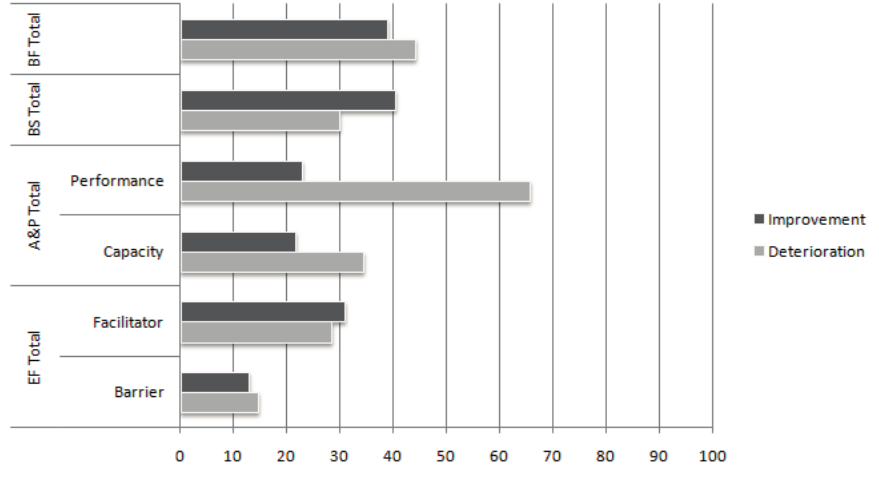
Figure 2. Comparison of the percentage of patients who improved or deteriorated on the various International Classification of Functioning, Disability, and Health domains with respect to the number of problems (extension index) between T0 and T1. The number of problems of the remaining patients did not